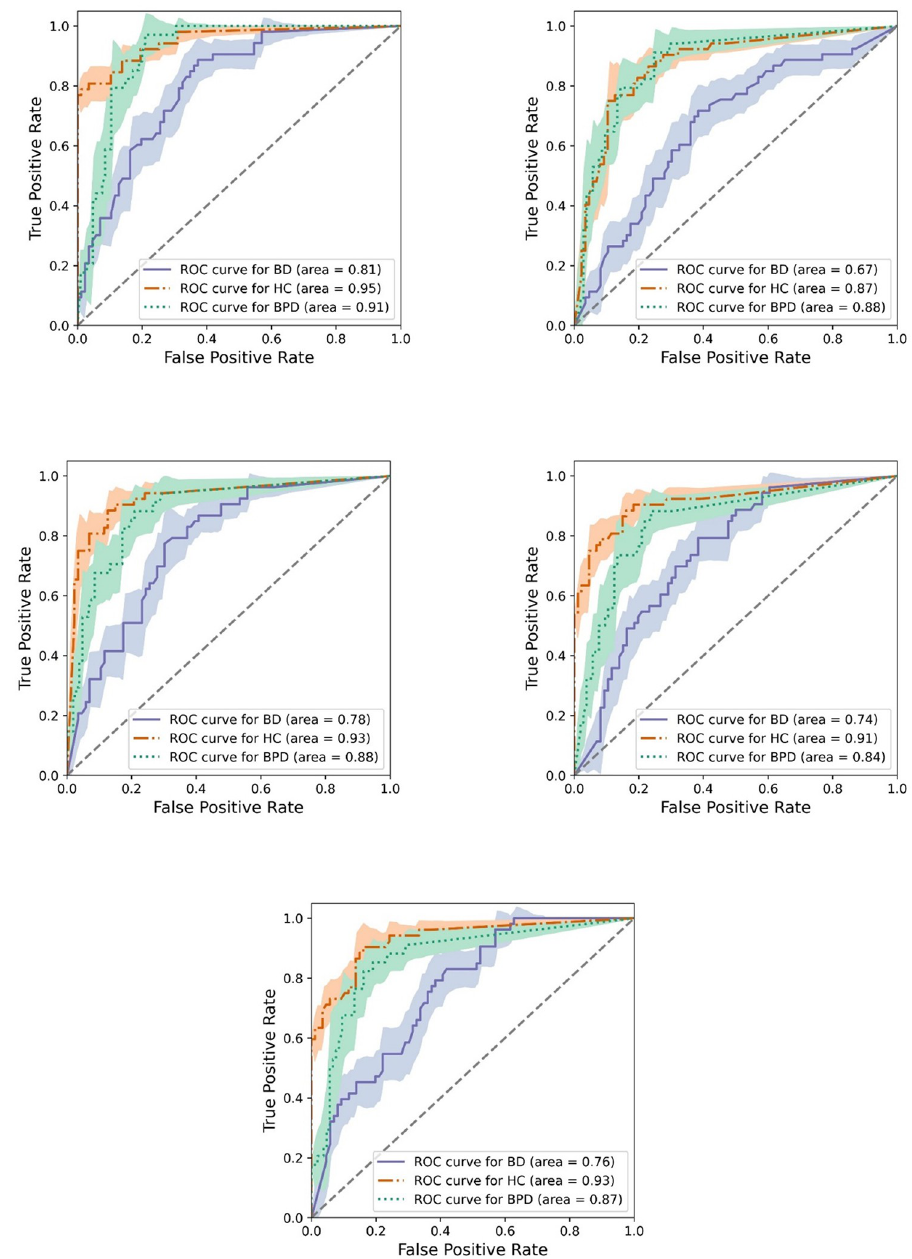
Fig 5. Receiver operating characteristic curves with 95% confidence interval for all models. Upper: MRSCM (left) and naive model (right); Middle: KNN (left) and PPCA (right); Lower: rfMICE.